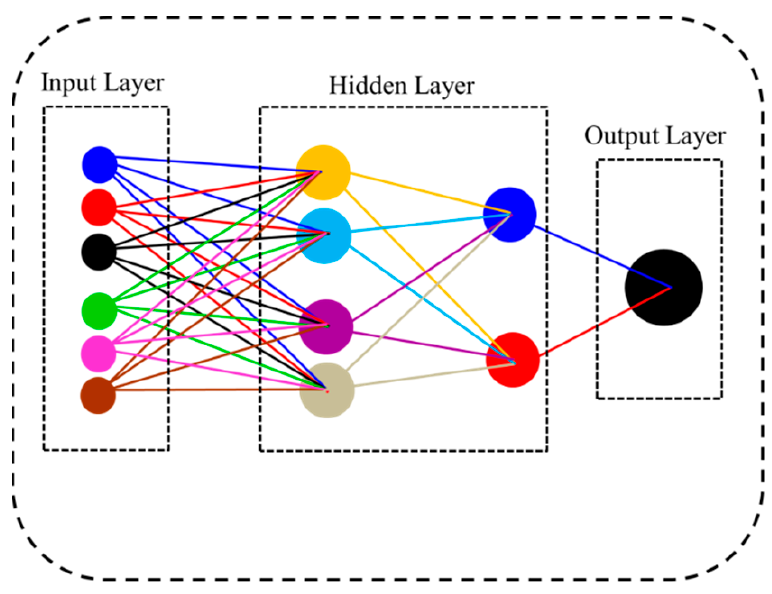
Figure 6. Multi ‐ layer perceptron neural networks. Figure 6. Multi-layer perceptron neural